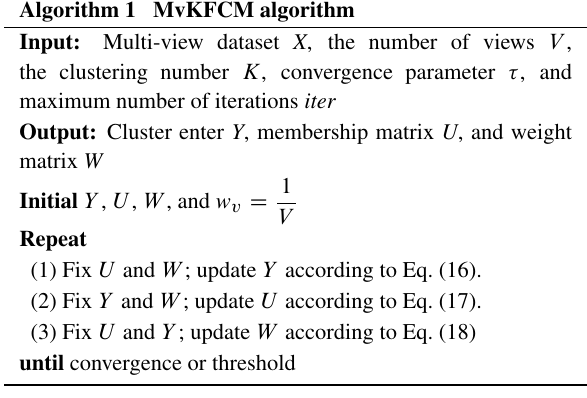
Algorithm 1 MvKFCM algorithm